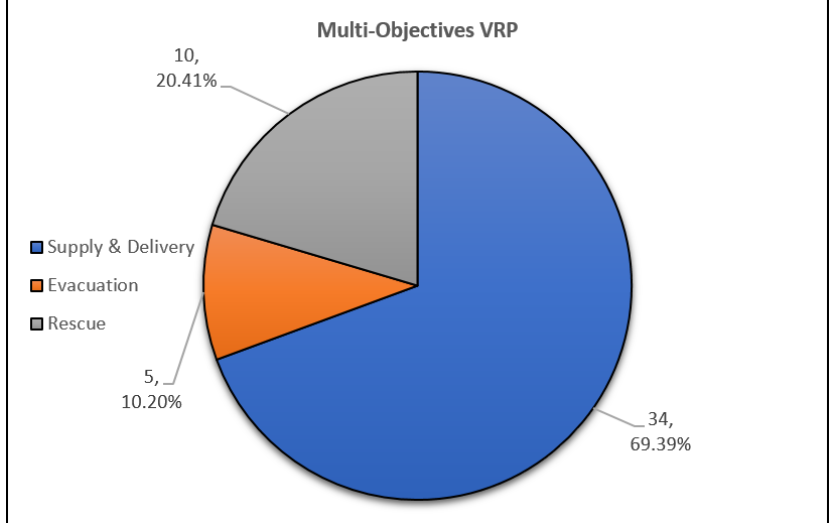
Figure 19. Selected Humanitarian Operation based on Multi-Objectives VRP.